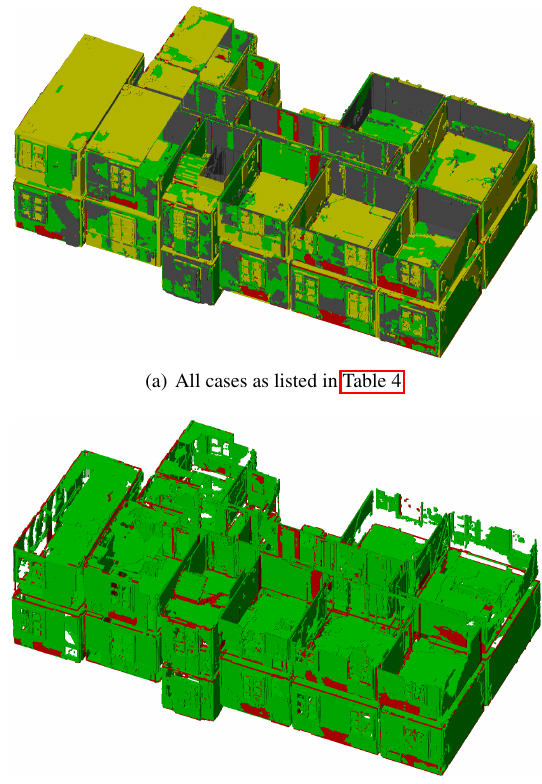
(b) Only voxels that are not empty in the reconstruction as well as in the ground truth model. Figure 4. Spatial distribution of correctly and wrongly classified voxels for the reconstruction of the axes-aligned model from Fig- ure 3(b). The voxels are colourized according to Table 4. A part of the ceiling is removed for the sake of